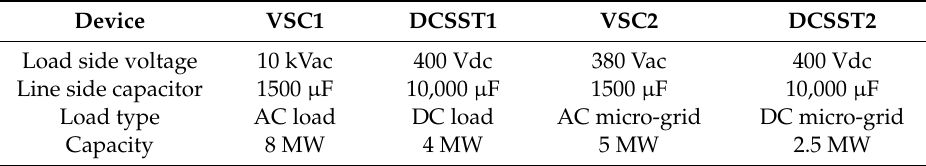
Table 2. Parameters of Plug-In Devices and